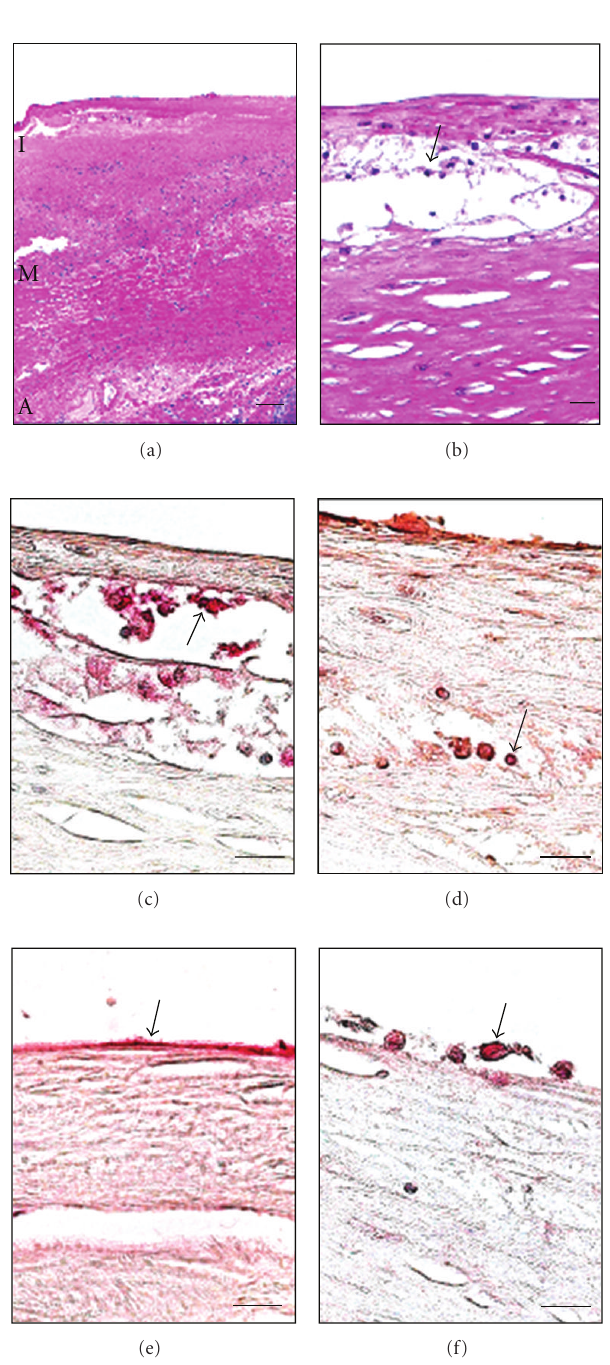
Figure 2: Histology of human AAA and double immunostaining of ephrin-B1 and others therein. (a)I, intima; M, tunica media; A, adventitia. Note severely destructed tunica media. Bars, 200 μ m. (b) Arrow indicates fatty streak in intima. Bars, 20 μ m. (c) and (d) Double immunostaining. Ephrin-B1 was stained with DAB (brown), the others with New Fuchsin (red). Bars, 20 μ